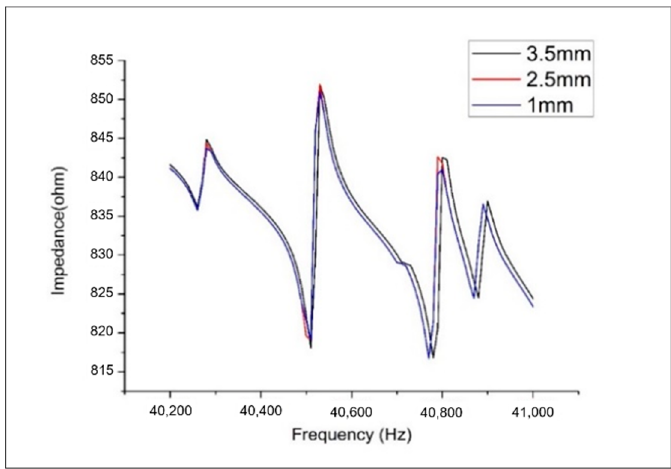
Figure 5. Convergence analysis of the numerical finite element model to calculate impedance responses with different mesh sizes.